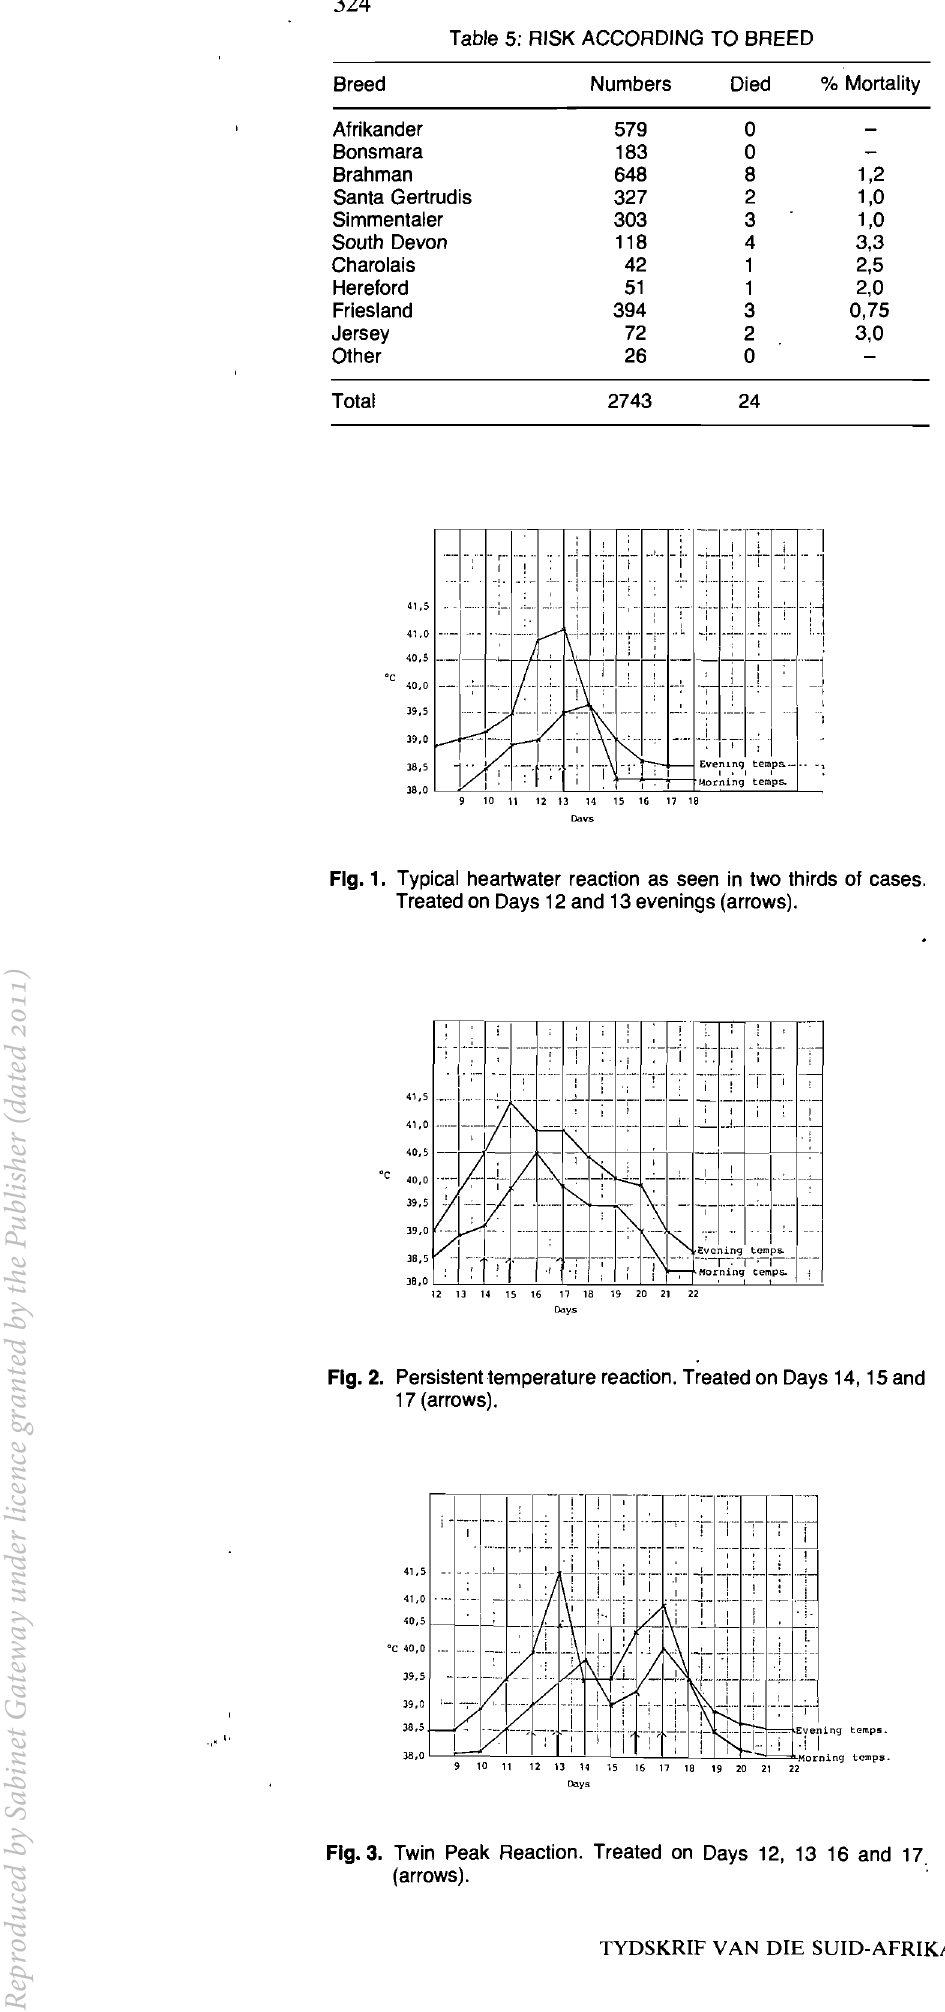
Table 5: RISK ACCORDING TO BREED